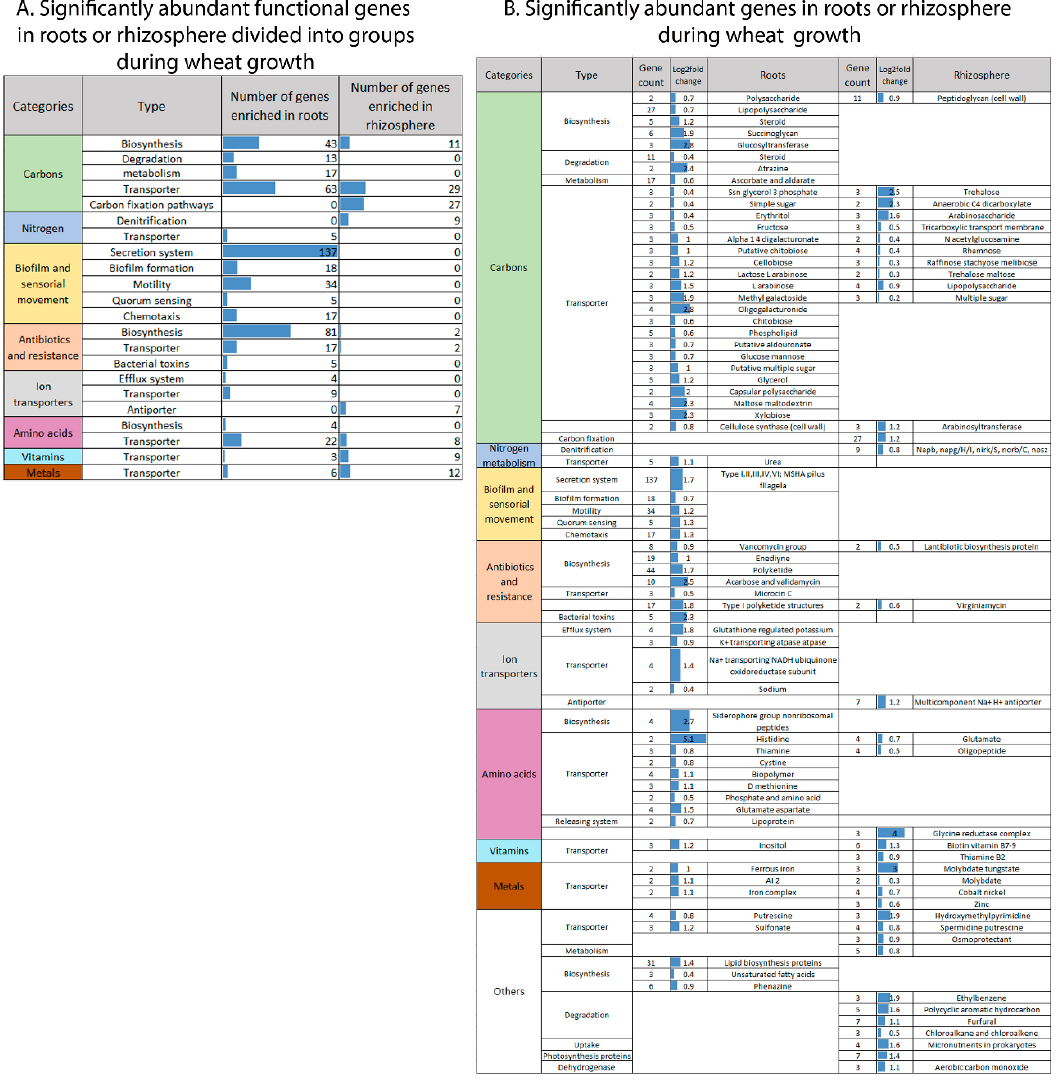
Figure 5. Spatial effect on microbiome functions. Significantly abundant functional genes in two niches (root-associated vs. rhizosphere) summarized in functional groups ( A ) and genes encoding for those functional groups ( B ).